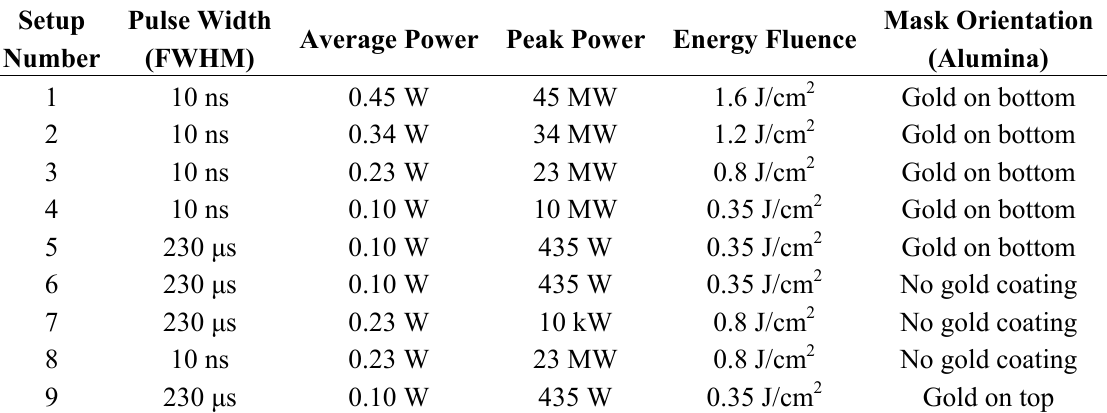
Table 1. Experimental trials and